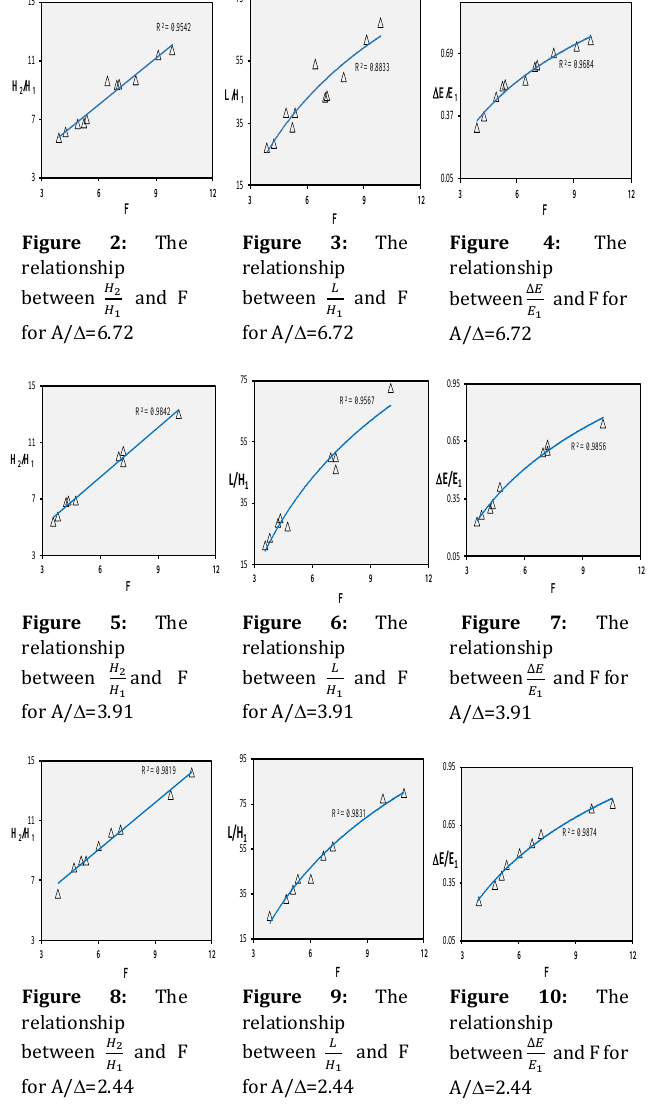
The 2 nd phase measurements surveys of the effect of the comparative